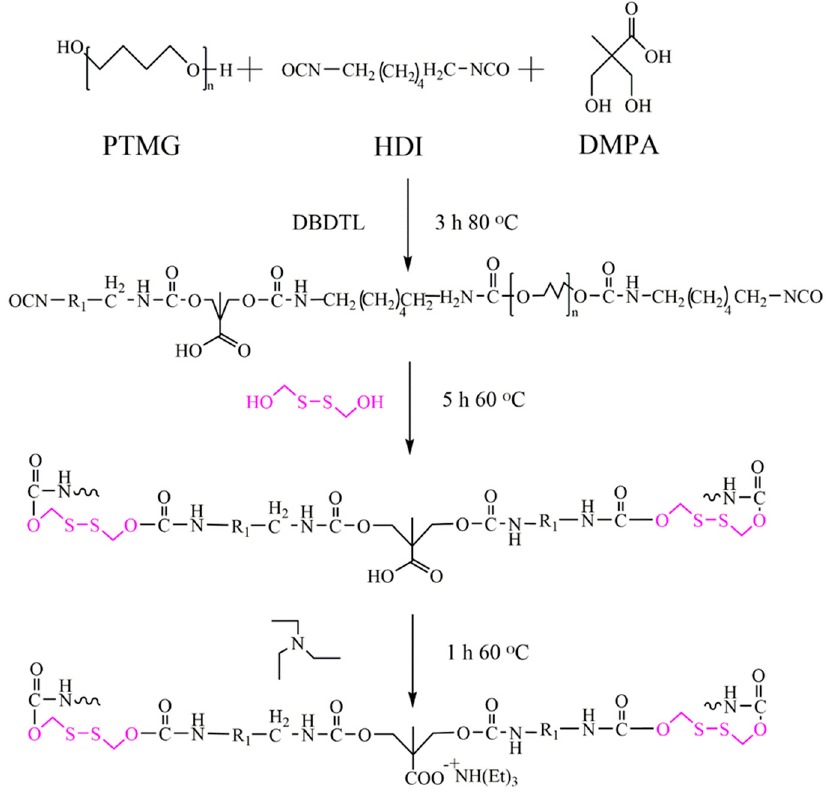
Figure 1. The synthesis process of WPU2 (R1 is the repeating chain segment).